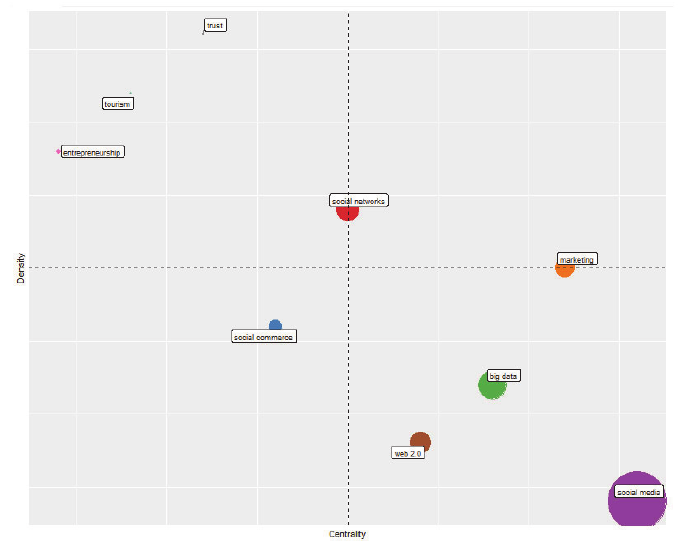
Fig.9. Thematic Map